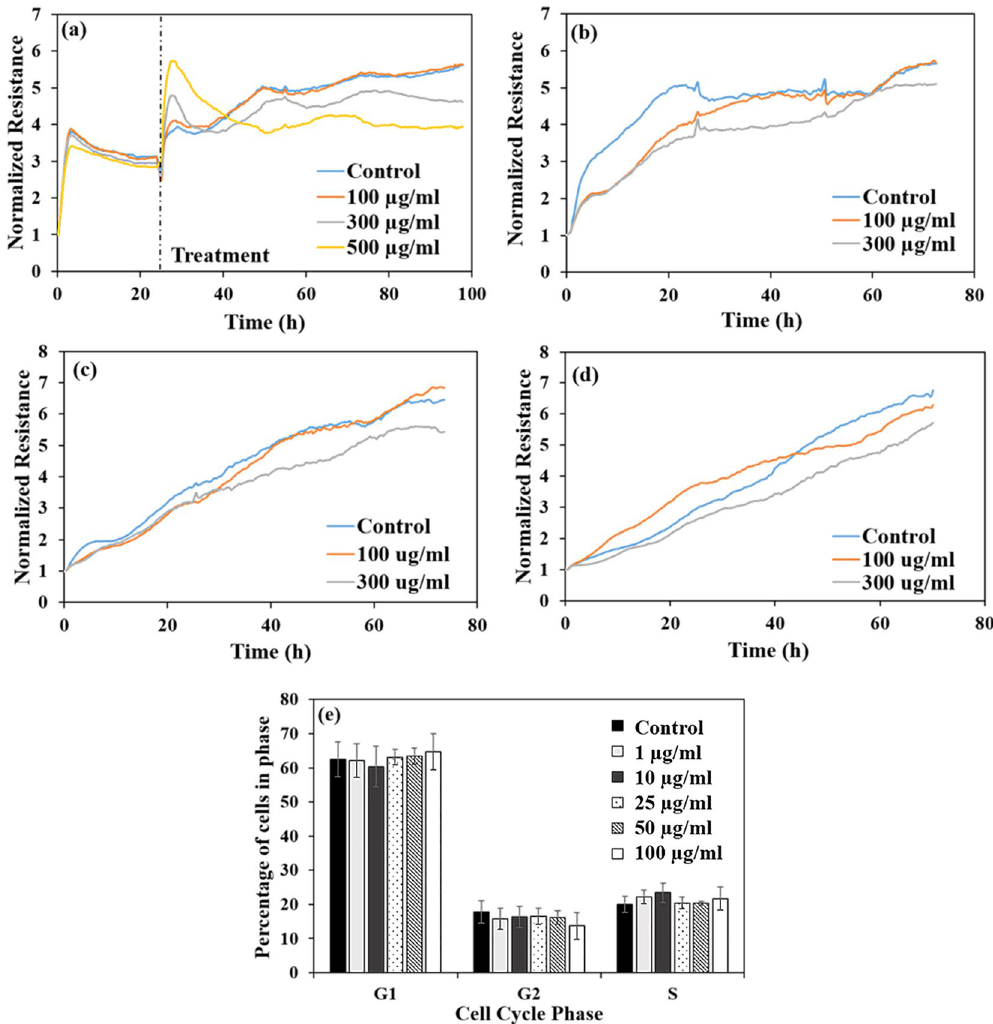
Figure 6. ( a ) Representative real-time measurements of normalized resistance for BEAS-2B cells before and during exposure to PLACC900 from 100–500 µ g/ml. Representative real-time measurements of normalized resistance for the recovery of BEAS-2B cells over 72 h after exposure to PLACC900 for ( b ) 24 h, ( c ) 48 h, and ( d ) 72 h. ( e ) Percentage of cells in the G1, G2, or S phase of the cell cycle after exposure to 1–100 µ g/ml PLACC900 (n =